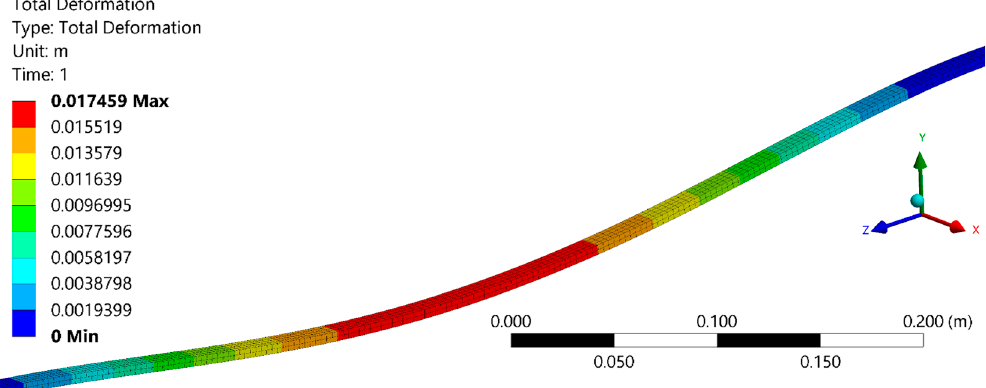
Figure 3. Numerical simulation of Configuration 1 with a force applied on the center of the optical- fiber-embedded sensor system.